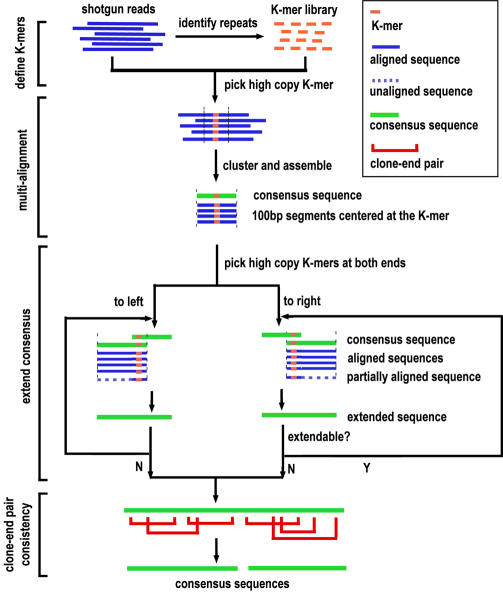
The ReAS AlgorithmWe start by computing K-mer depth, which is the number of times that a K-mer appears in the shotgun data. Copy number refers to how often a K-mer appears in the assembled genome. Depth divided by copy number is the coverage. We seed the process using a randomly chosen high-depth K-mer. All shotgun reads containing this K-mer are retrieved and trimmed into 100-bp segments centered at that K-mer. When the sequence identity between them exceeds a preset threshold, they are assembled into an ICS using ClustalW. We perform an iterative extension by selecting high-depth K-mers at both ends of the ICS and repeating the above procedure. After all such extensions are done, clone-end pairing information is used to resolve ambiguous joins and to break misassemblies, but not to join fragmented assemblies. The final consensus is our ReAS TE.